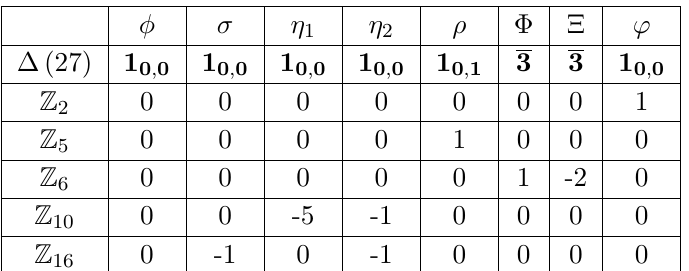
Z Z Z Z Z 2 (cid:2) 5 (cid:2) 6 (cid:2) 10 (cid:2) 16 . The scalar (cid:30) corresponds to (cid:2)